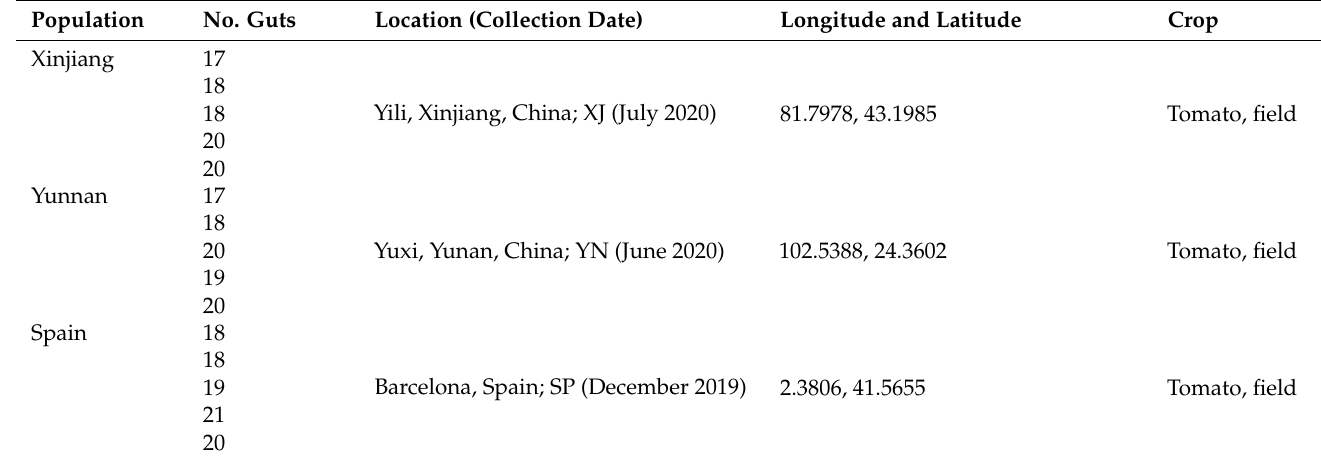
Table 1. Sampling locations and dates for the populations of Tuta absoluta